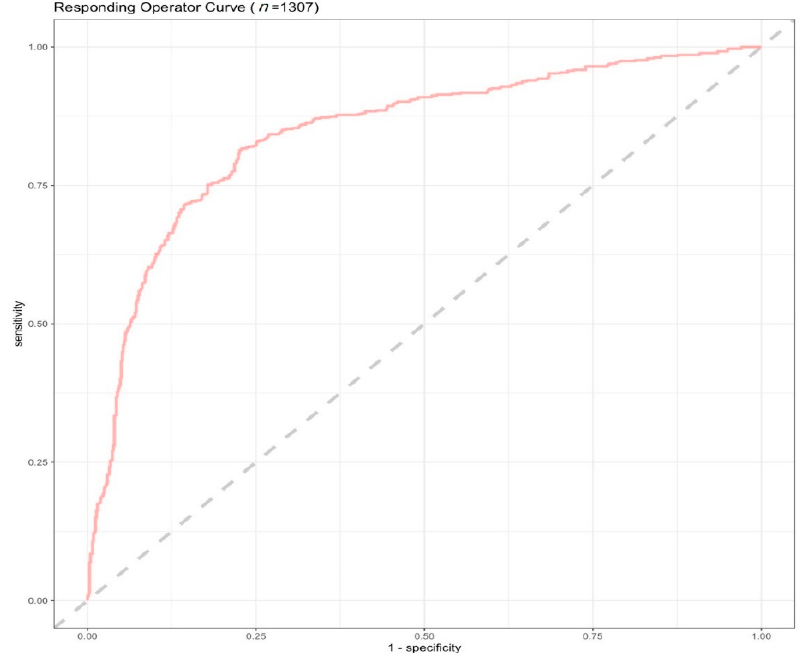
Figure 2. ROC curve of the final model in the test sample. A final AUC of 0.84 was